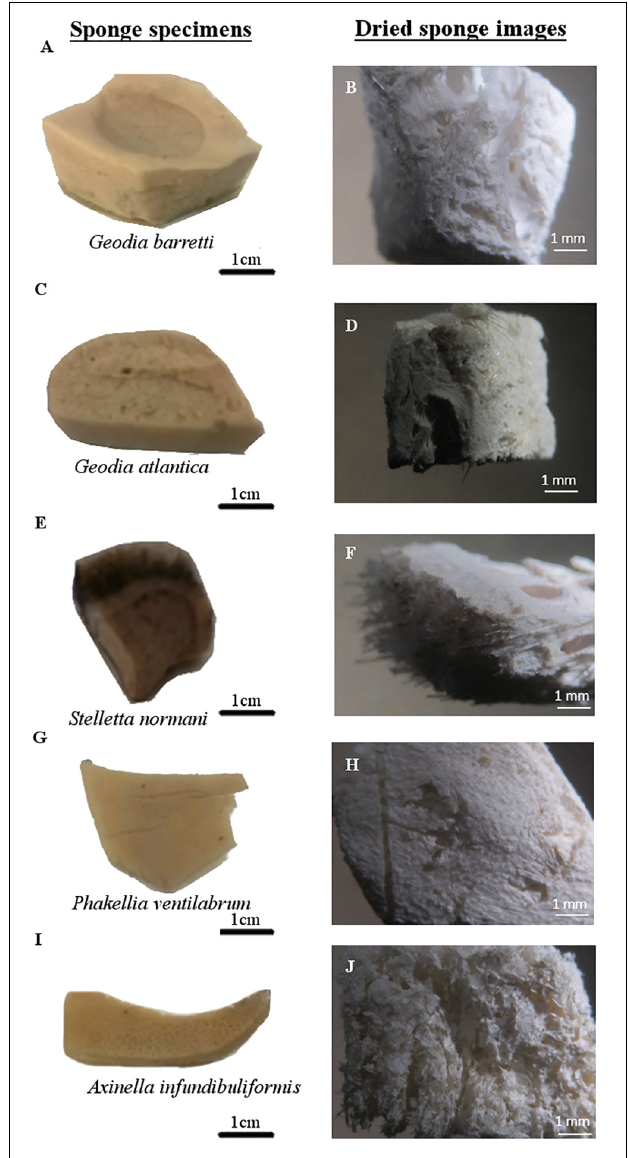
FIGURE 3 | North Atlantic marine sponge macrostructures. Sponge photographs of each specimen took after removal the absolute ethanol (A,C,E,G,I) and stereomicroscope images of sponge specimens after critical point drying (B,D,F,H,J) .